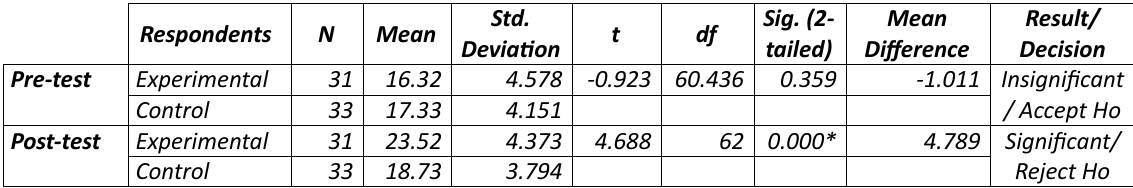
Table 1. Test of Diference on the Pre-test and Post-test Mean Scores of the